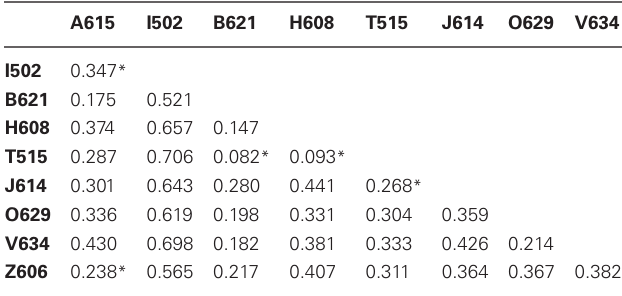
Hot spring abbreviations given in Table 1 . F ST values were tested for significance against 1000 randomized bootstrap resamplings; * indicates P >